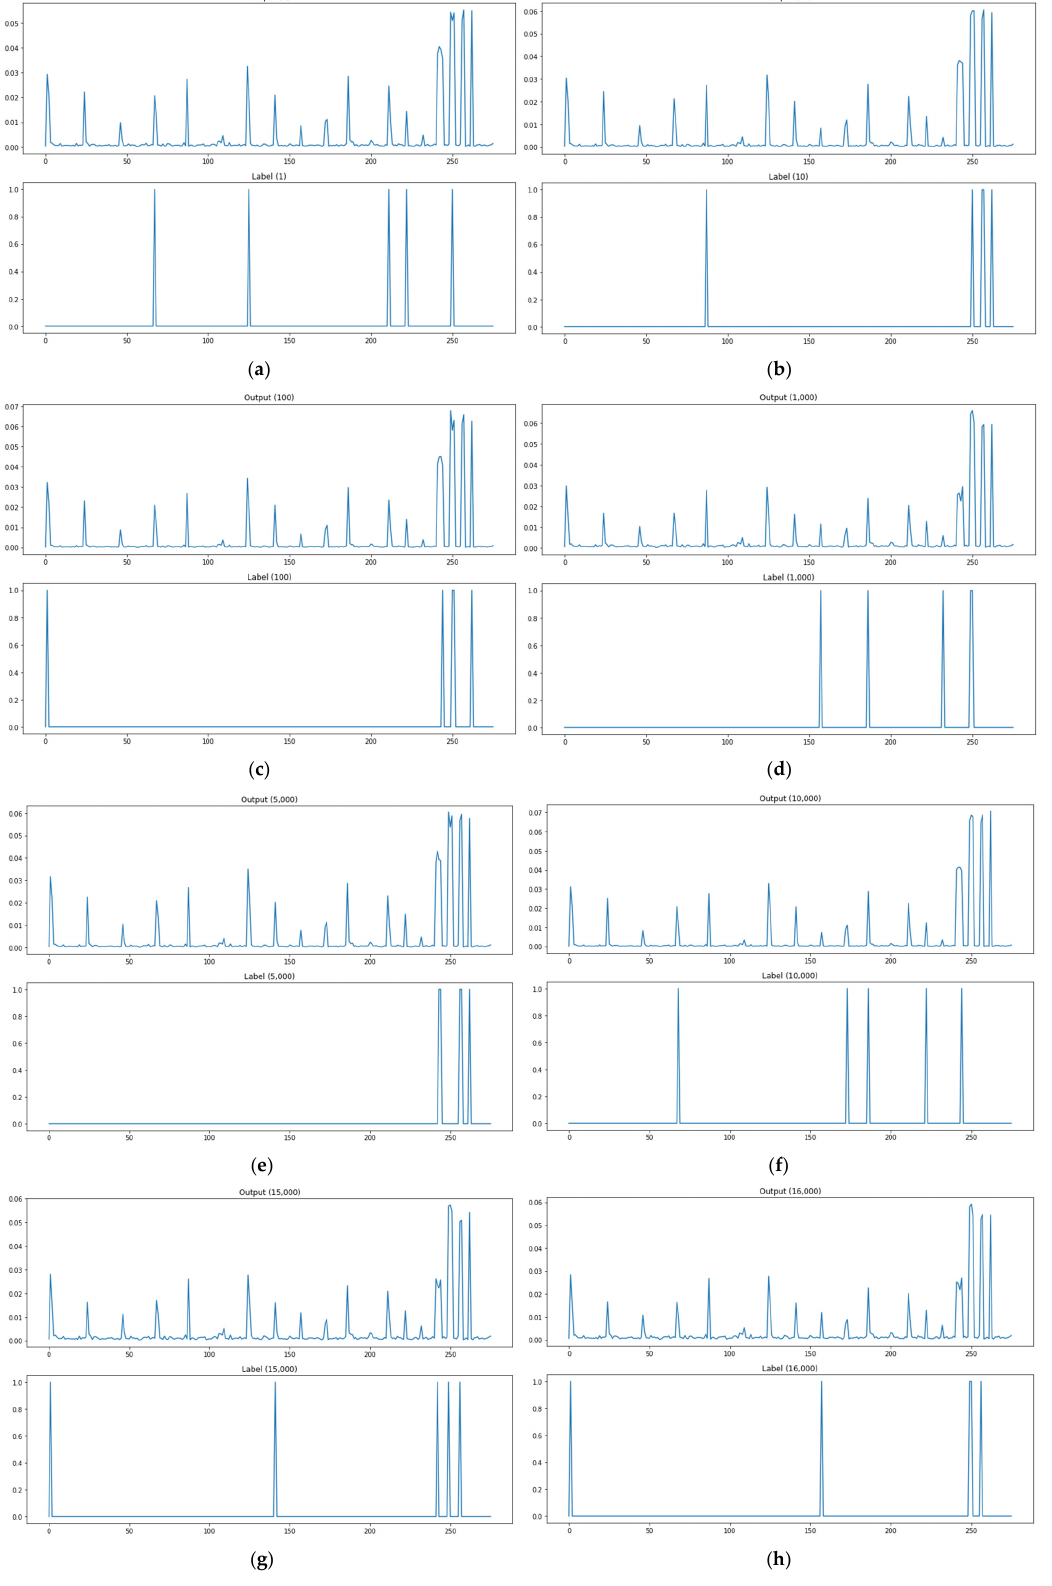
Figure 13. The outputs of the ANN and deep learning—output layer with Softmax (model 2). ( a ) Test data 1. ( b ) Test data 10. ( c ) Path test data 100. ( d ) Path test data 1000. ( e ) Path test data 5000. ( f ) Path test data 10,000. ( g ) Path test data 15,000. ( h ) Path test data